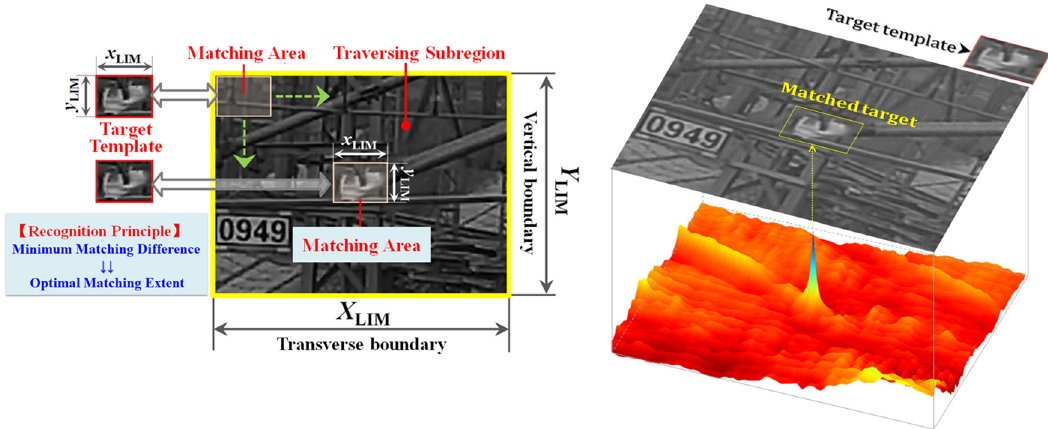
Figure 17: Target template matching and 3D contour plot of matching difference [ 47 ]